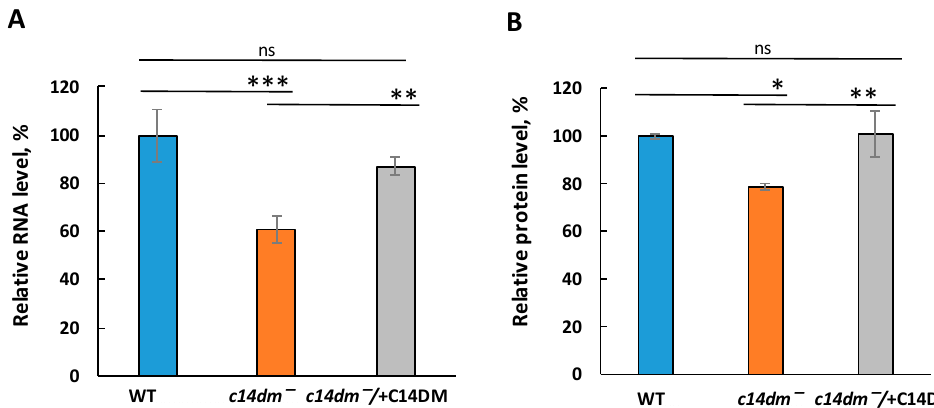
Figure 1. The total RNA and protein levels are reduced in c14dm ̅ mutant. ( A ) The total RNA was extracted from 1 × 10 7 cells of WT, c14dm ̅ and c14dm ̅ / + C14DM cells and quantified using NanoDrop in relation to WT. ( B ) The total protein levels from 1 × 10 7 cells of WT, c14dm ̅ and c14dm ̅ / + C14DM were measured using BCA assay, and their relative levels were calculated in relation to WT. ns: not significant; *: p < 0.05; **: p < 0.01; and ***: p < 0.001.